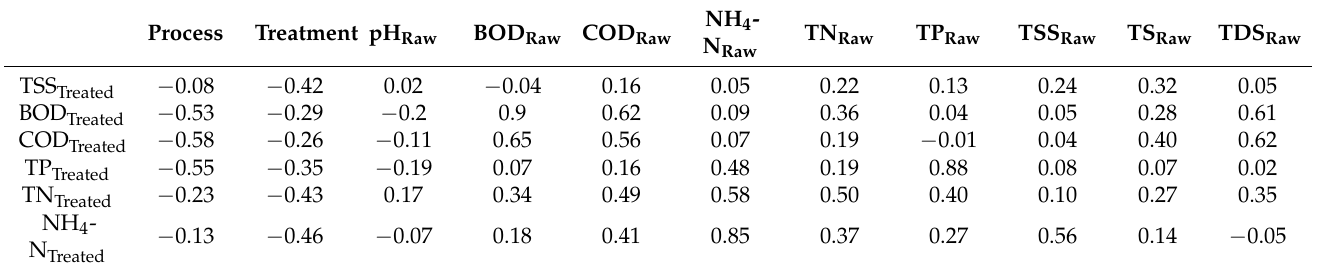
Table 3. The correlation matrix between independent and dependent variables.